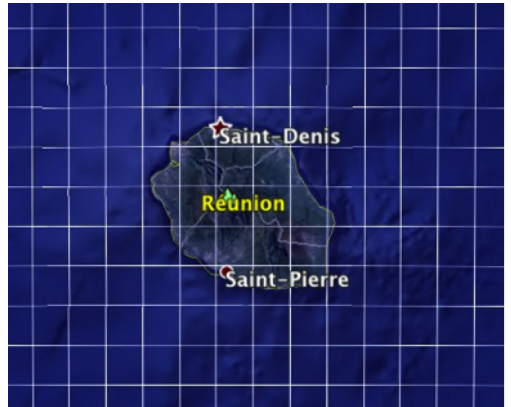
Figure 2. ECMWF grid for La Réunion